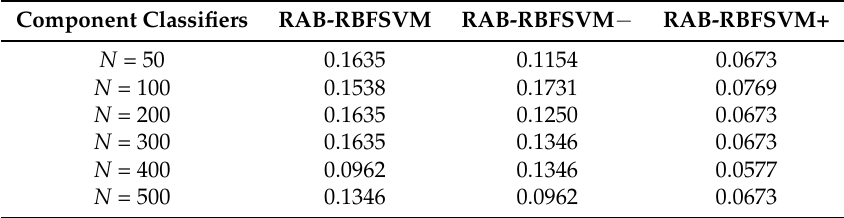
Table 4. Errors of RAB-RBFSVM and RAB-RBFSVM+ in different numbers of cycles.